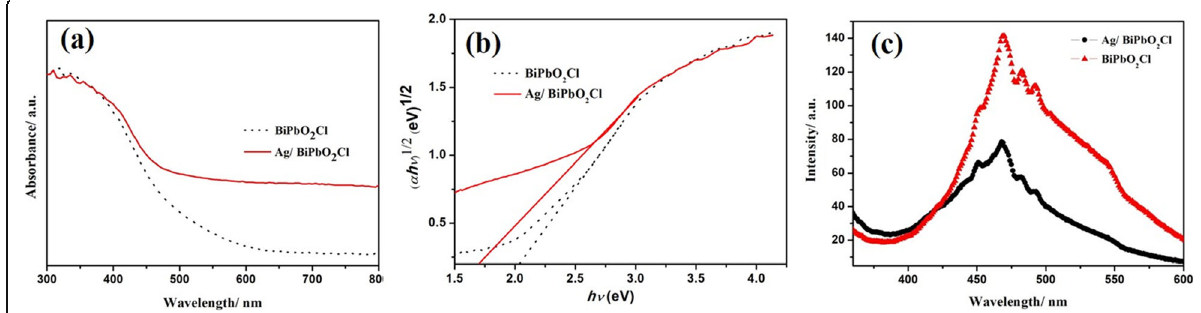
Fig. 5 The UV-vis absorption spectra ( a ) and photoluminescence emission spectra ( b ) of BiPbO 2 Cl and 0.5 wt% Ag/BiPbO 2 Cl composites ( c )